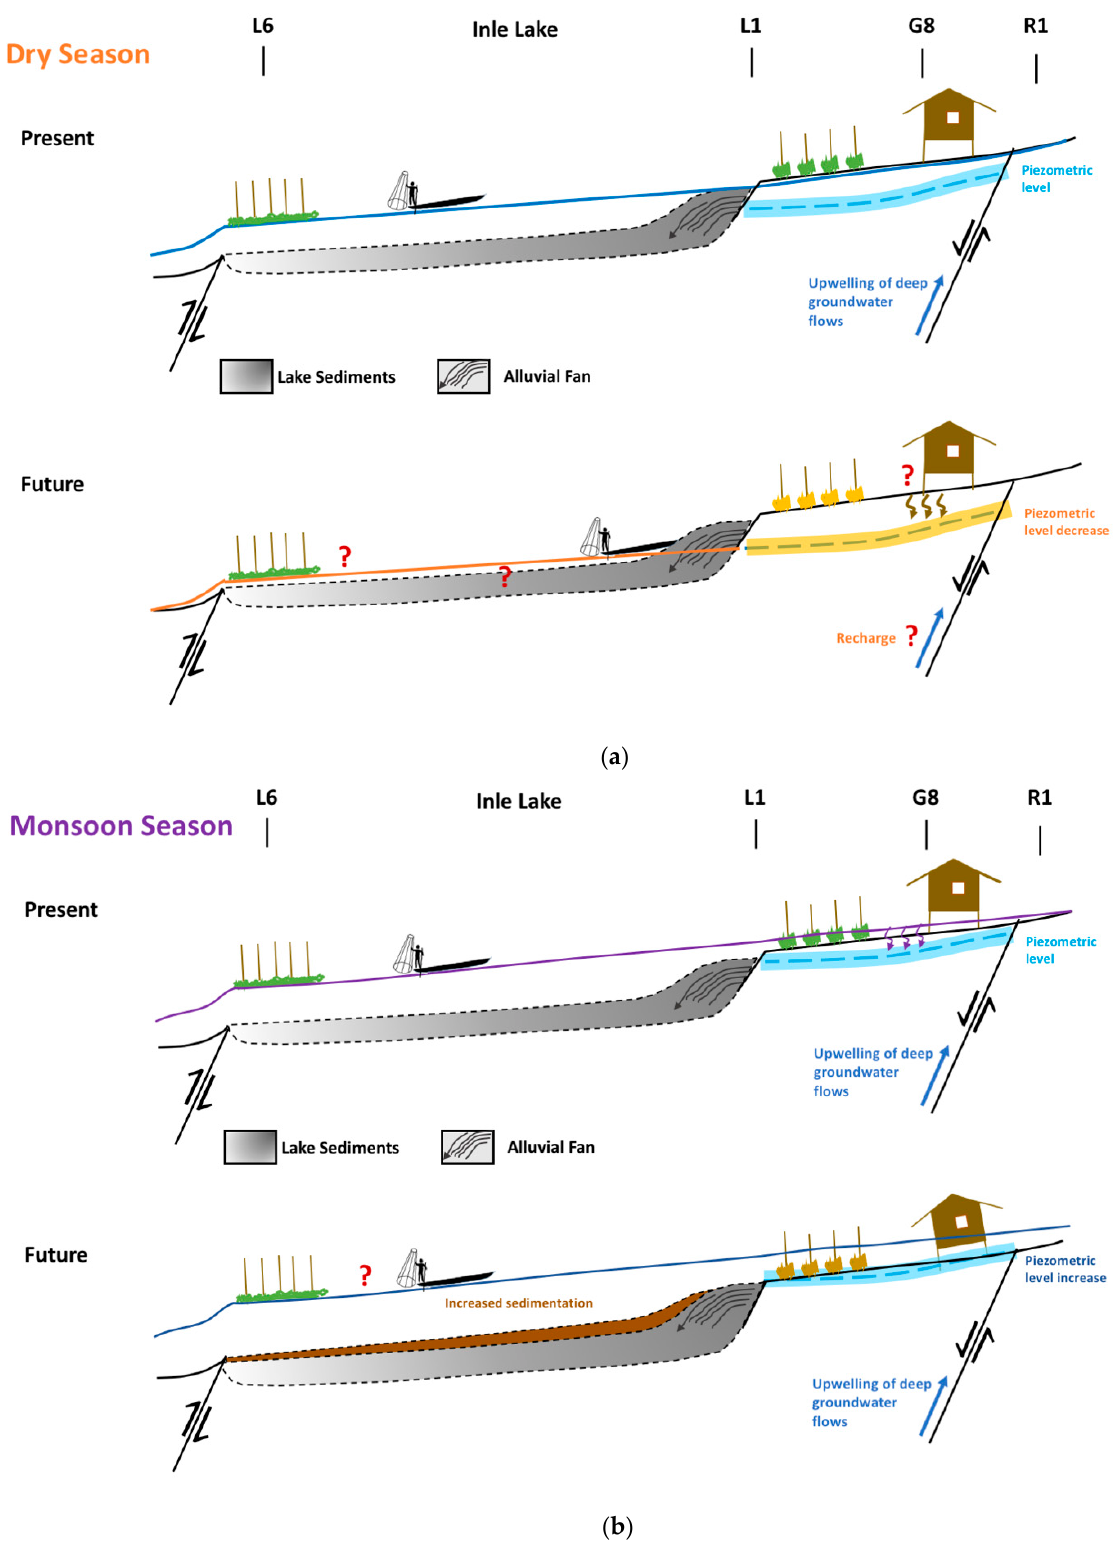
Figure 9. Schematic representation of the possible water volume changes in the Inle Lake area in both the ( a ) dry season and ( b ) rainy season. Modified after [28]. The red question marks indicate potential criticalities requiring further investigation.